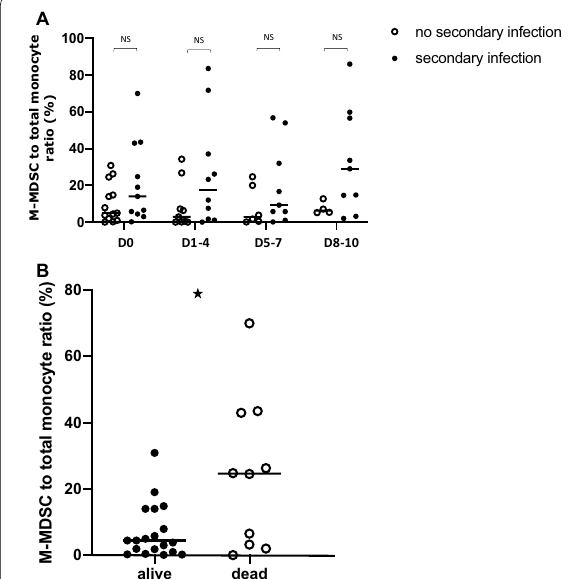
Fig. 3 Monocyte myeloid‑derived suppressor cells kinetics. Monocyte myeloid‑derived suppressor cells (M‑MDSC) kinetics from admission to day 8–10 in patients with secondary infection ( a ) or survivors at day 28 ( b ). ** p <